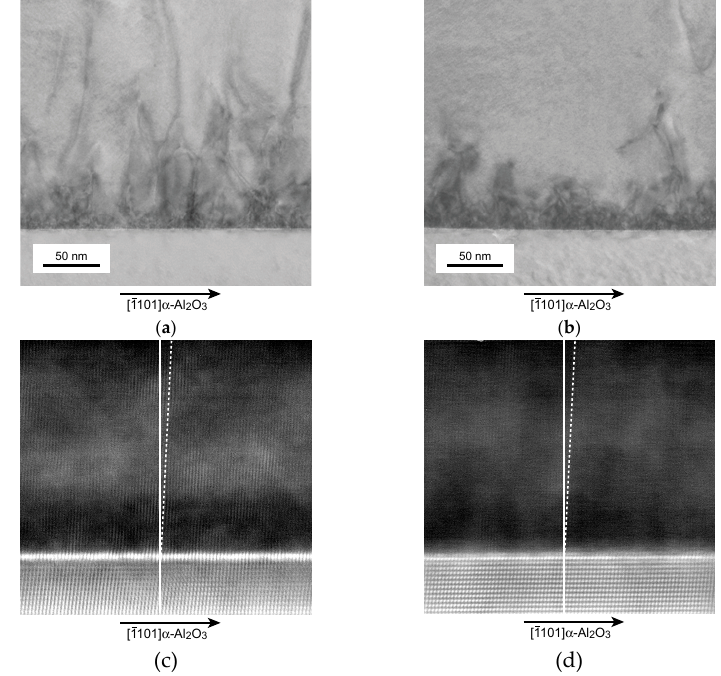
Figure 7. Transmission electron microscopy (TEM) and magnified images of the interface between the ScN films and α -Al 2 O 3 grown under T Sc = 1320 ◦ C ( a , c ) and T Sc = 1325 ◦ C ( b , d ). The white lines indicate the film growth direction. The dotted lines depict [100] of ScN. Both films are grown at 900 ◦